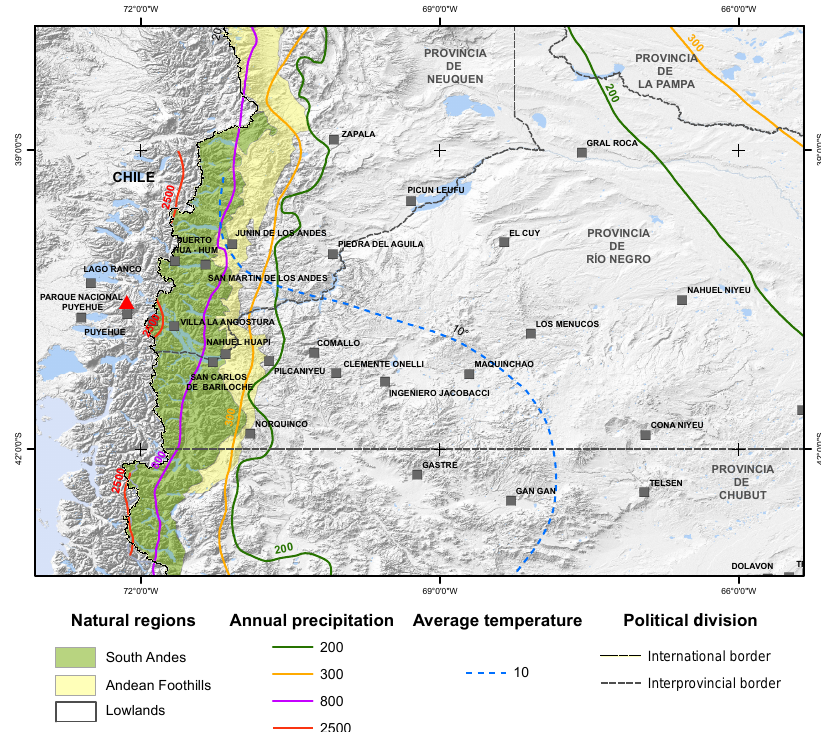
Figure 2. Natural regions of the northern portion of Argentine Patagonia, modified from Bran et al. (2000, 2002). The solid lines represent the average annual precipitation and the dashed line represents the average annual temperature (taken from INTA, Instituto Nacional de Teconología Agropecuaria and SMN, Servicio Meteorológico